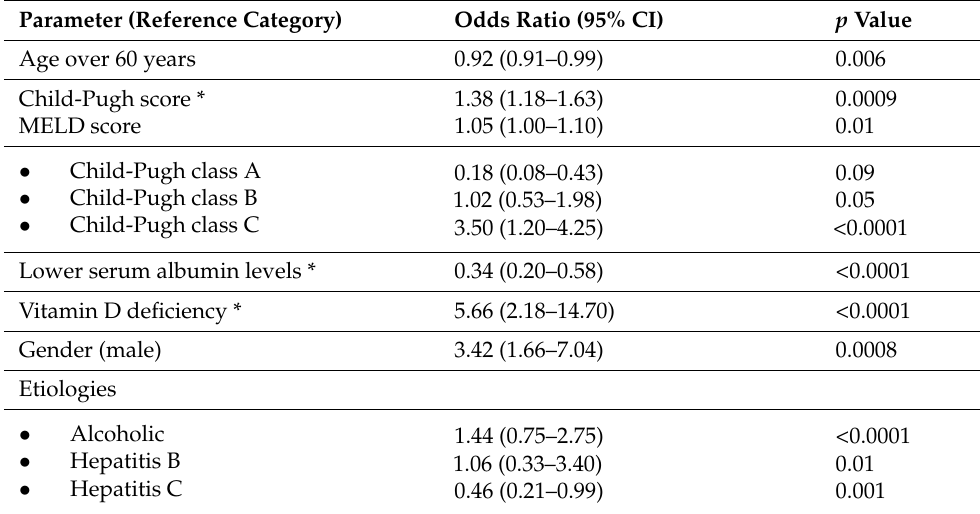
Table 2. Univariate logistic analysis of factors associated with malnutrition.